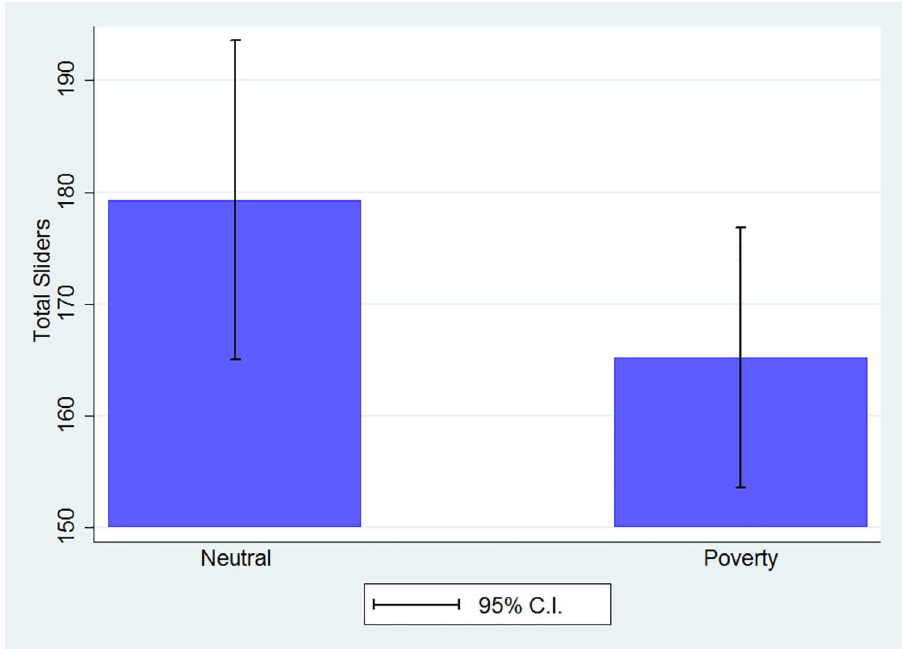
Fig 1. Average performanceby